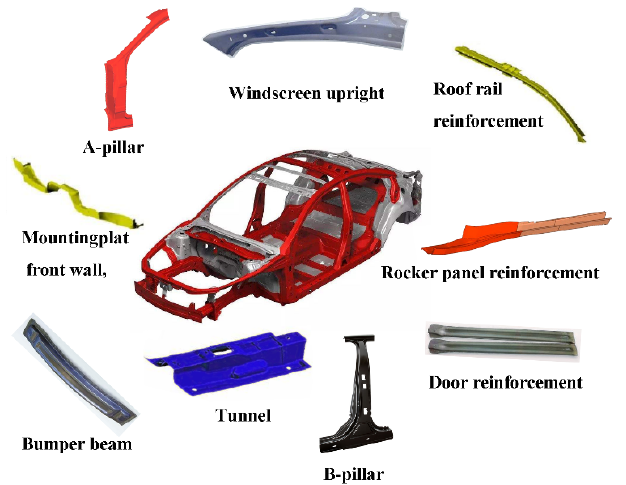
Figure 5. Typical application of PHS (shown in red) in automobiles [44]. This figure is reproduced based on